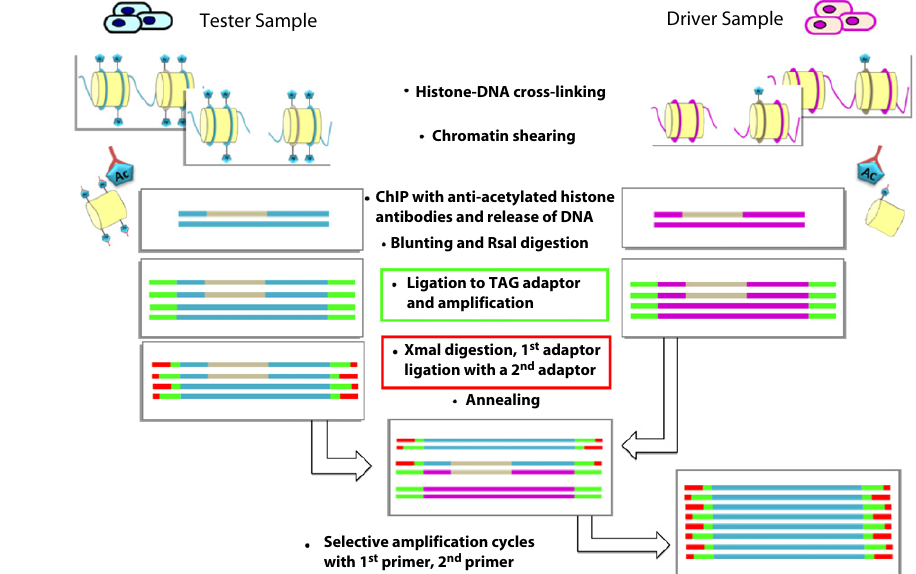
Figure 7. The differential chromatin scanning (DCS) method. DNA fragments bound to acetylated (Ac) histones from the tester cells (cells treated with HDAC inhibitors) are purified by immunoprecipitation and subjected to TAG adaptor ligation (green bars) and PCR amplification. The tester DNA is then digested with XmaI, ligated to the first subtraction adaptor (red bars), and annealed with an excess amount of the driver DNA. Given that only the tester specific fragments self-anneal, PCR with the first subtraction primer selectively amplifies these fragments.TheproductsaresubjectedtoasecondroundofsubtractionPCRwiththesecondsubtractionadaptor and primer to ensure the fidelity of the